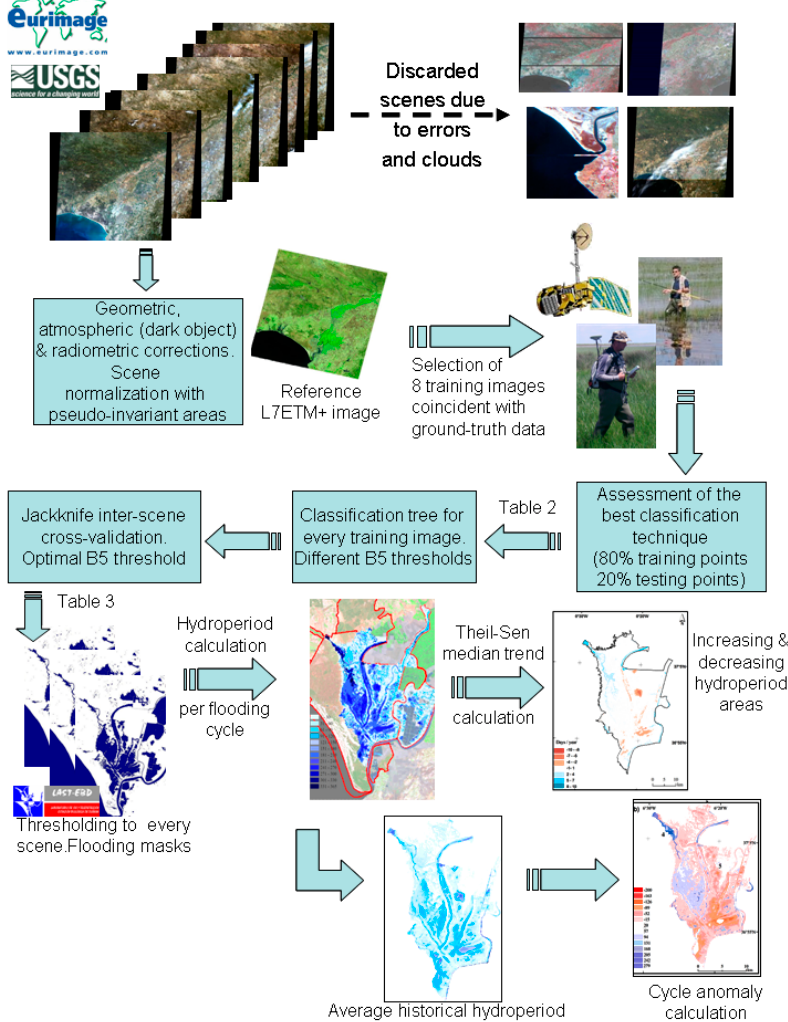
Figure 3. Flowchart of the methodology followed in the study.